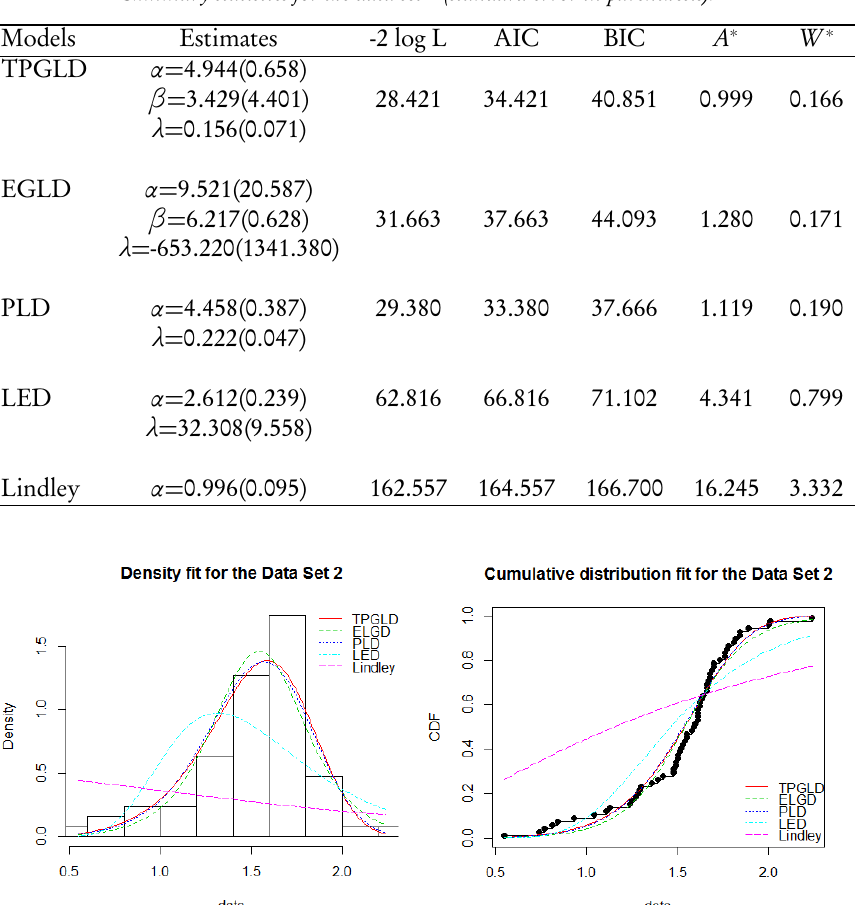
Summary statistics for the data set 2 (standard error in parenthesis).